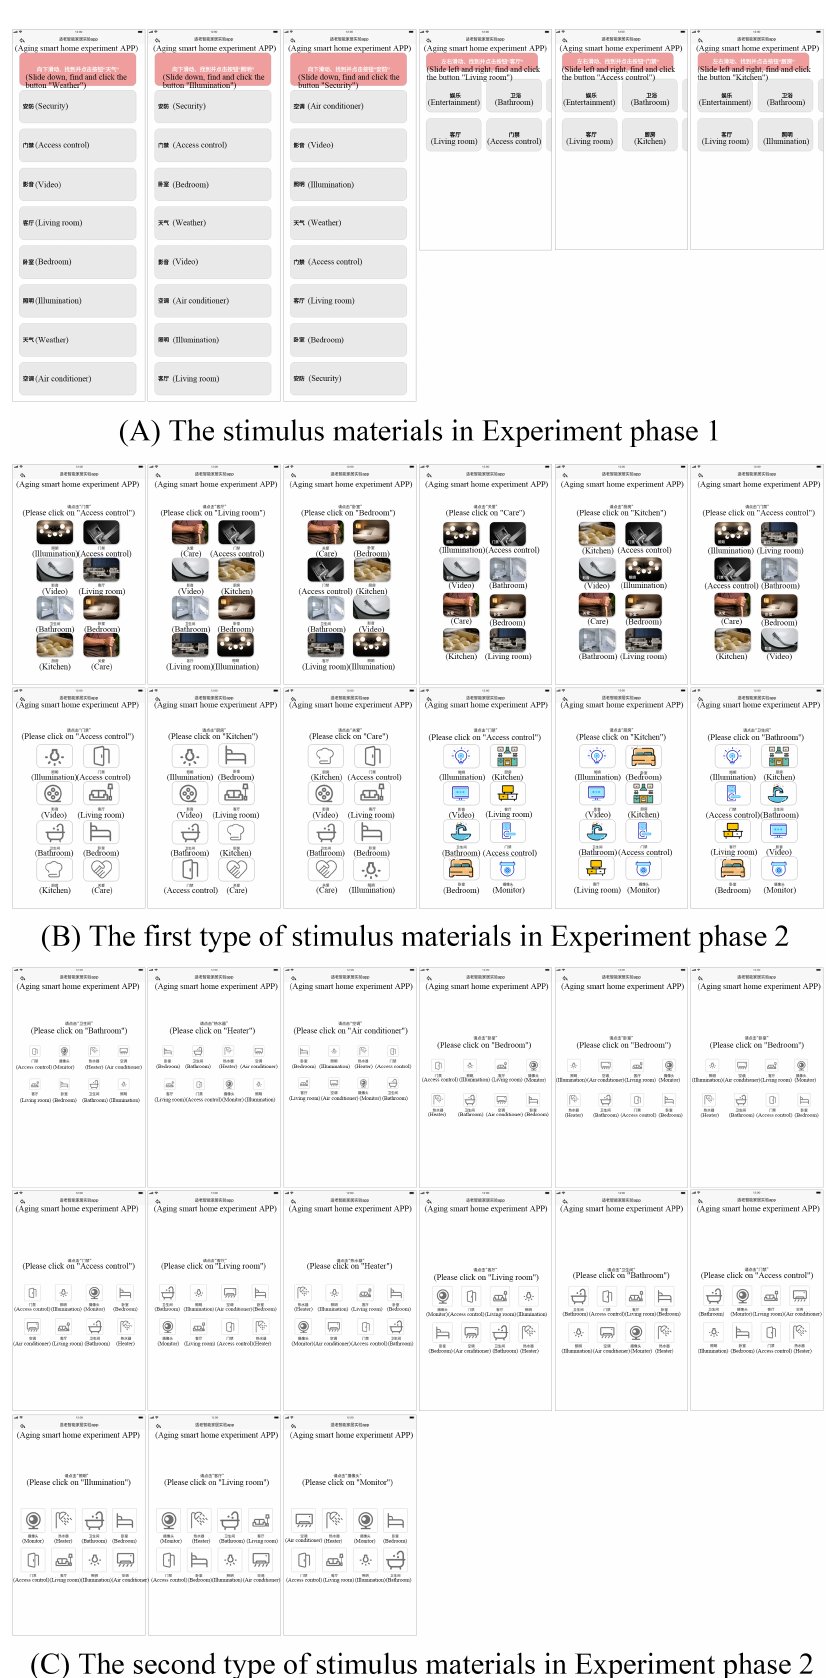
Figure 1. Experimental stage 1 stimulus